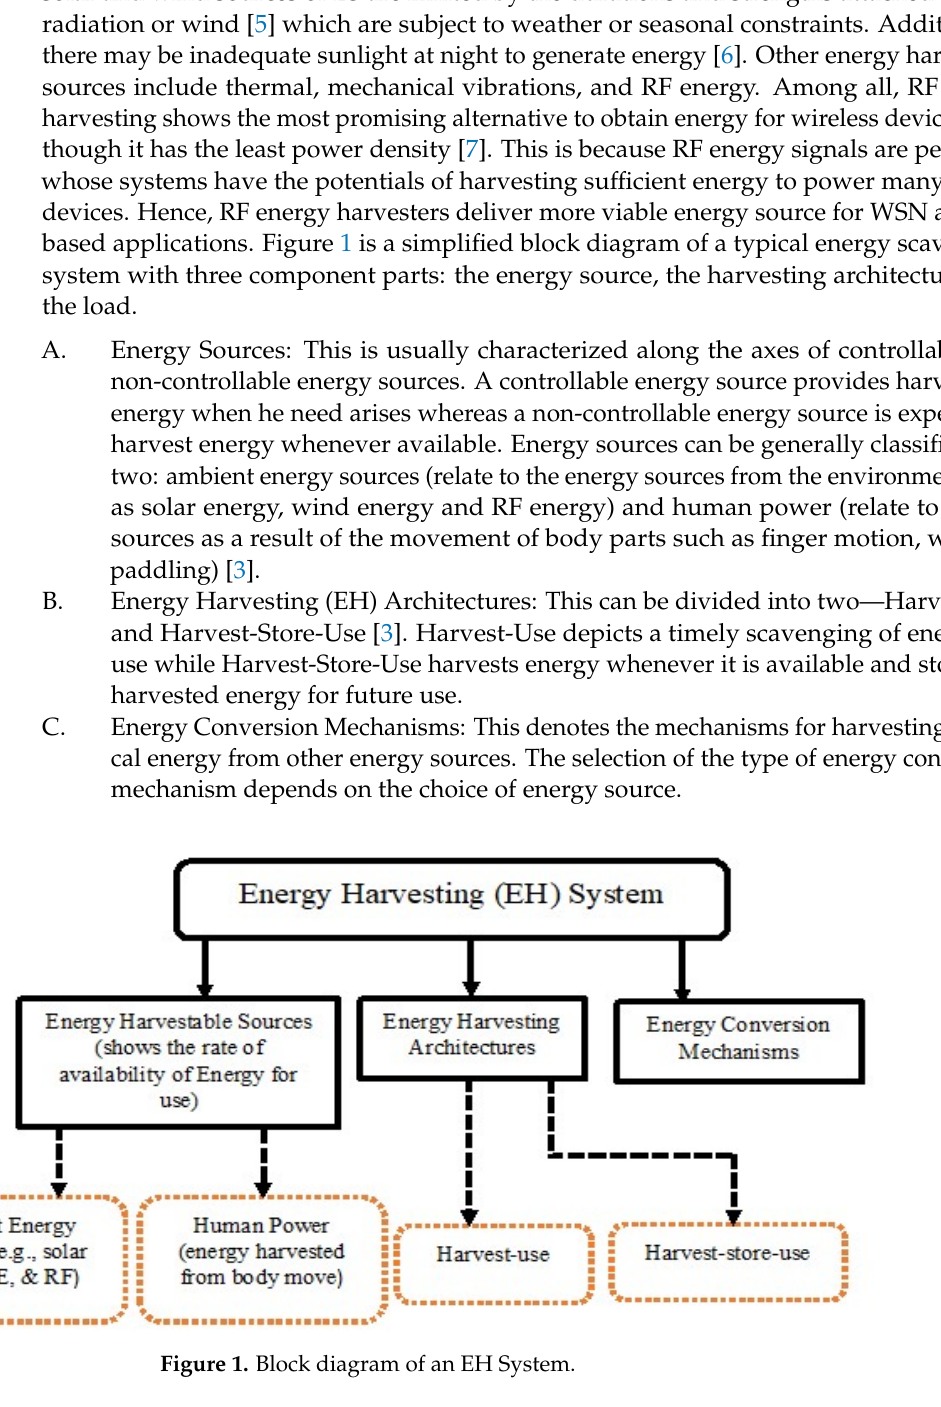
Figure 1. Block diagram of an EH System.